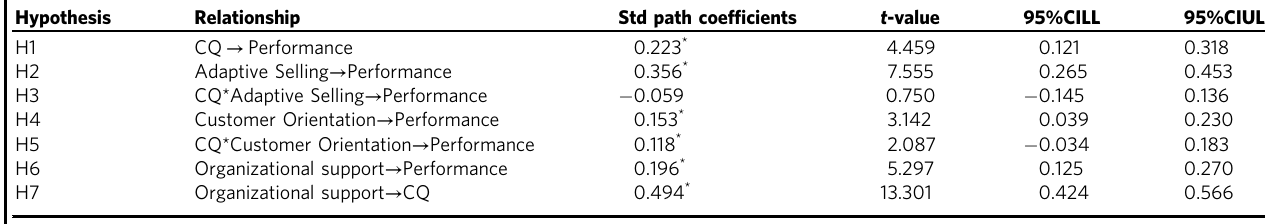
Table 8 Path coef fi cient veri fi